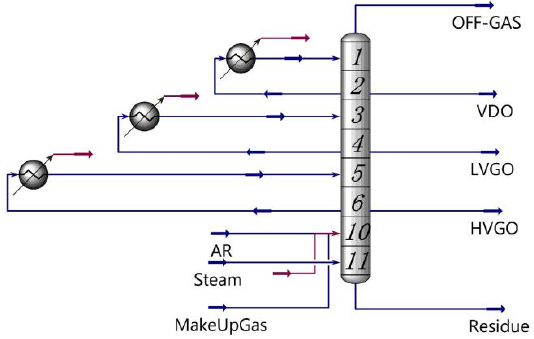
Figure 5. Vacuum column environment of the rigorous model of VDU in Aspen HYSYS.